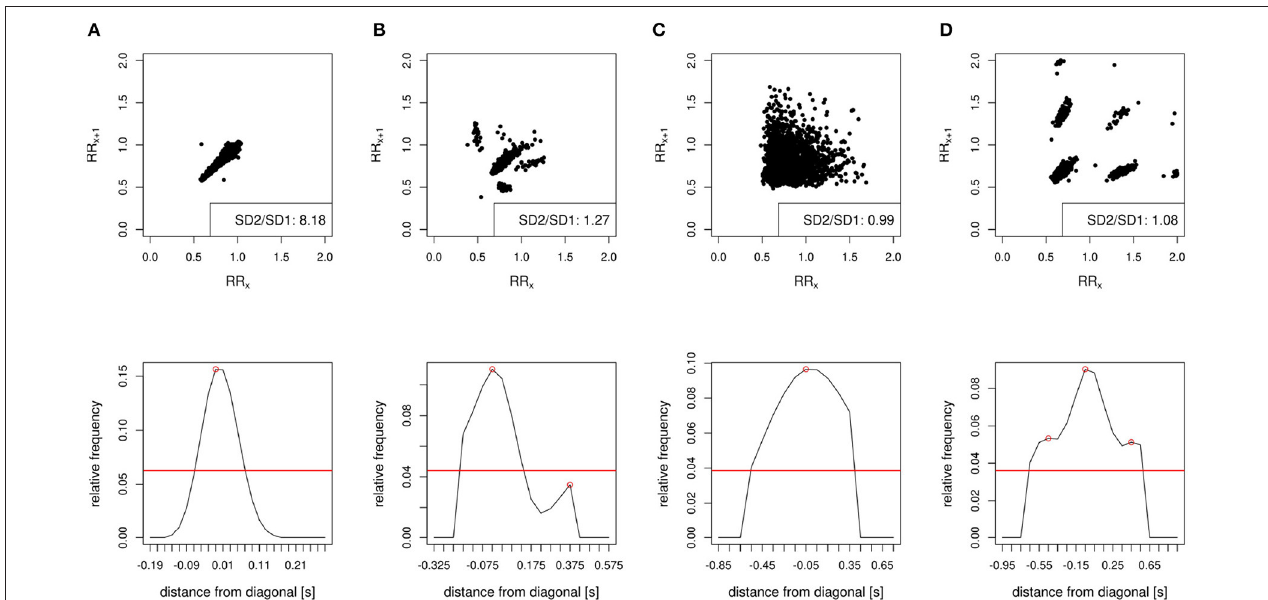
FIGURE 1 | Lorenz plot patterns and their corresponding smoothed histograms of SD1. The plots show 30-min chunks of different measurements that were used in the analysis as an example of different Lorenz plot patterns. The Poincaré plots in the top show a (A) comet, (B) side lobe pattern, (C) fan pattern, and (D) island pattern. The corresponding plots below show the histograms after smoothing. The lobe, fan, and island patterns have an SD2/SD1 ratio of less than 1.5 and would, therefore, be excluded. The histogram of the island patterns includes more than one local maximum, which is another criterion for exclusion. Data: (A) nsr008 from NSR2DB , (B) nsr018 from NSR2DB , (C) 01 from LTAFDB , and (D) f018 from CRISDB